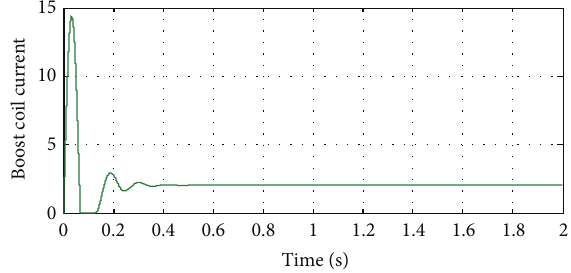
Figure 15: Line to line (B-C) voltage of inverter without implement- ing